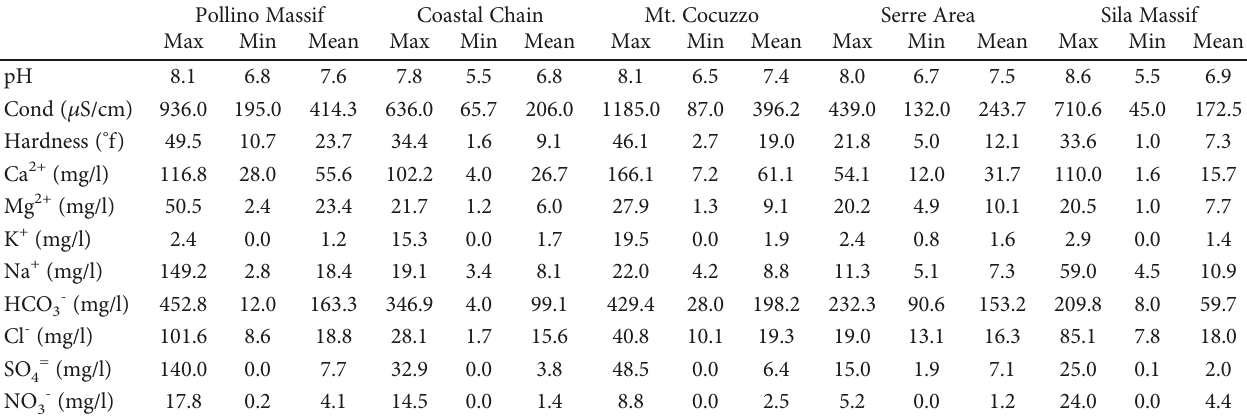
Table 1: Maximum, minimum and mean concentration values of the water parameters in the 5 subzones. Pollino Massif Coastal Chain Mt. Cocuzzo Serre Area Sila